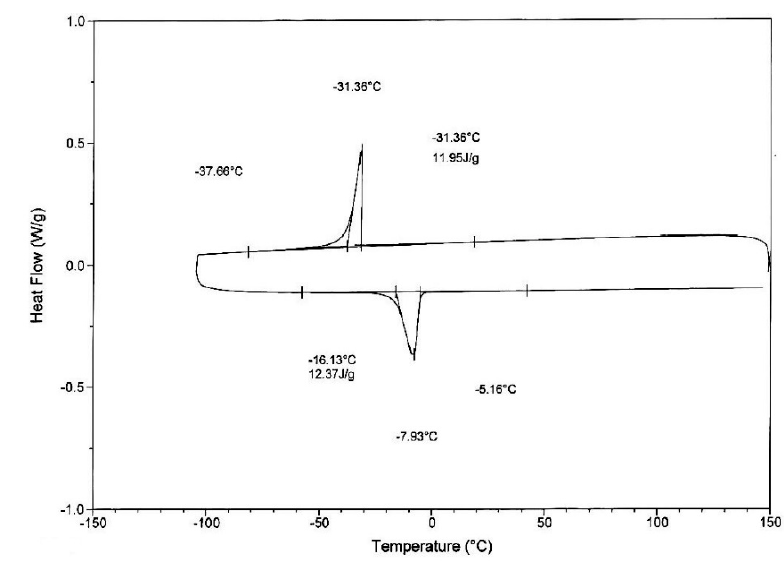
Figure 3. DSC experiment.